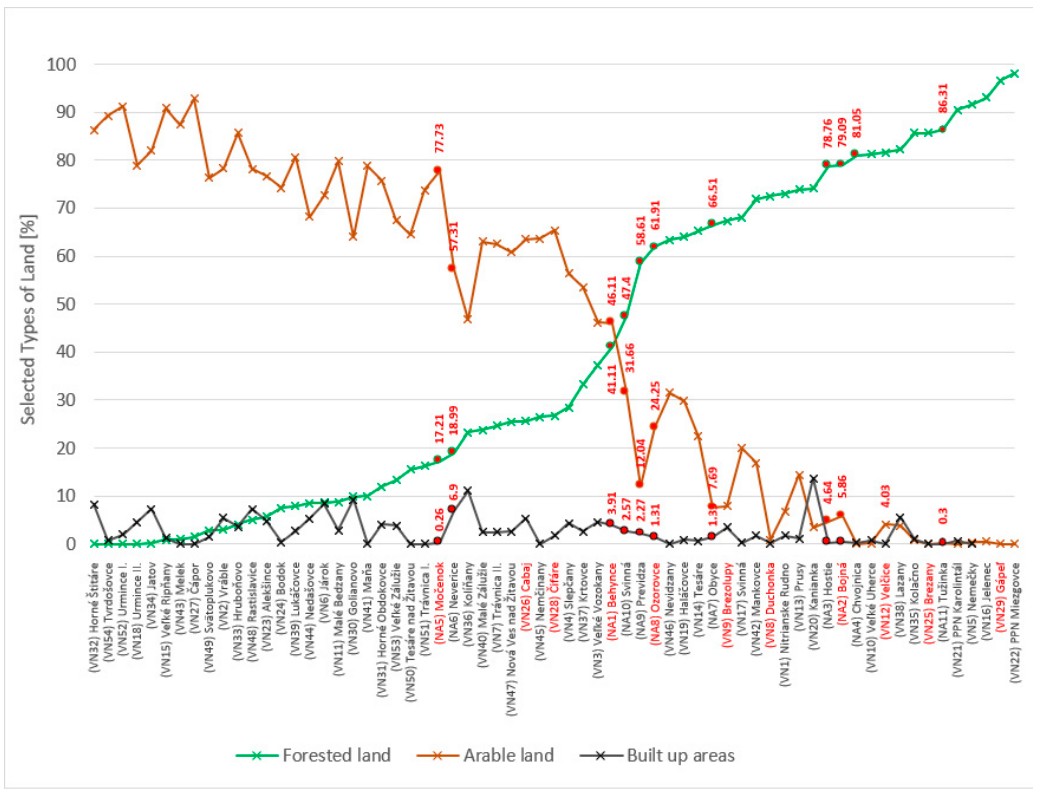
Figure 3. The Percentage of selected types of land.